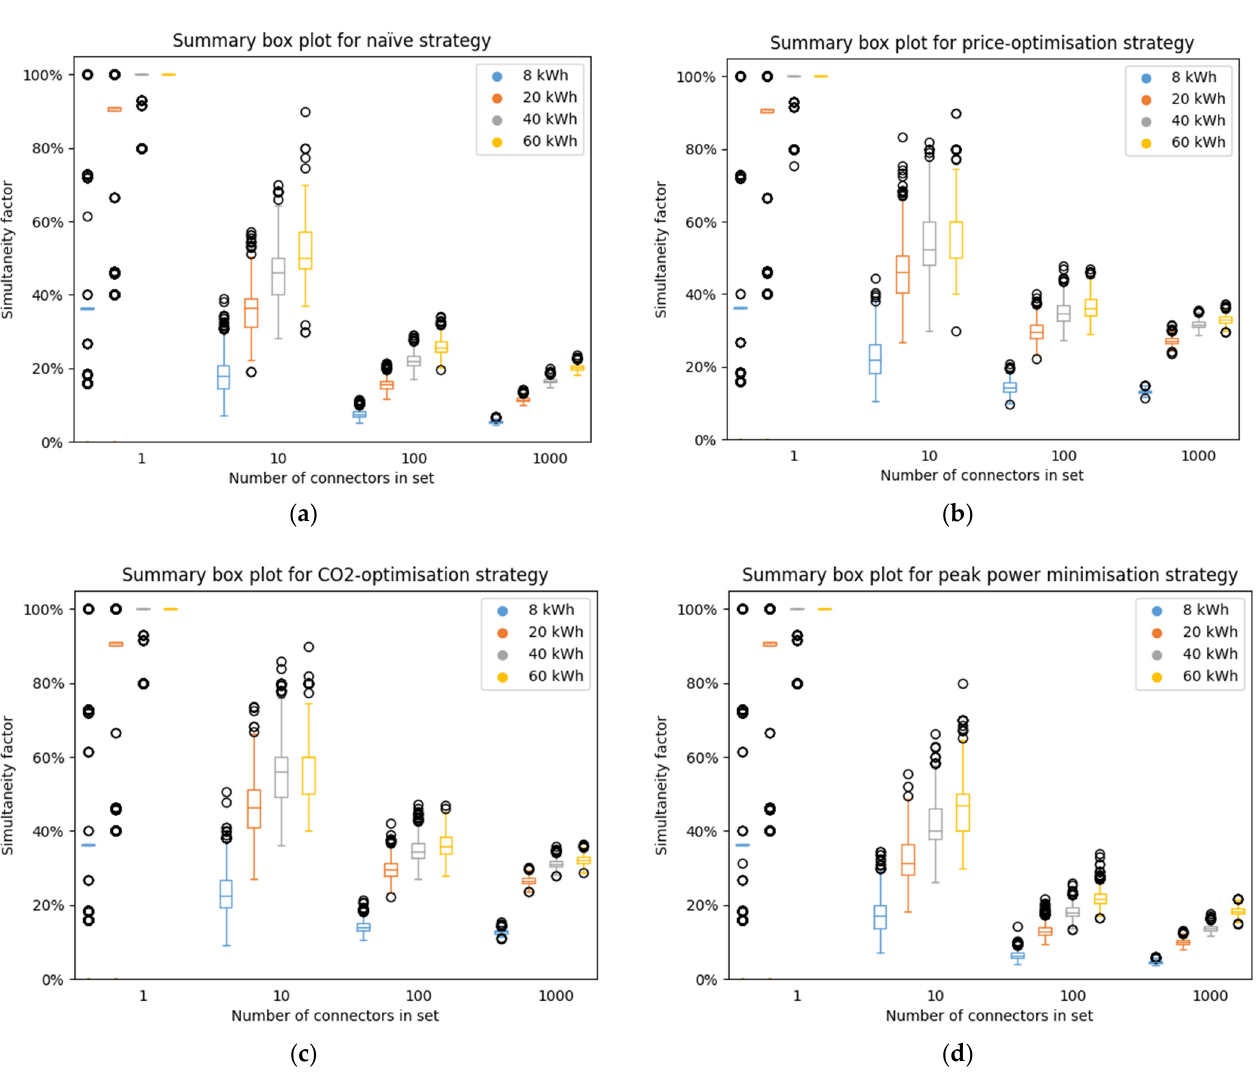
Figure 18. Summary of the simultaneity factors assuming for ( a ) naive charging; ( b ) price-optimised charging; ( c ) CO 2 intensity optimised charging; ( d ) peak power optimised charging. The plots summarise the information given in Figures A3–A6. For each combination of number of connectors per set and energy per charge event, 1000 sets were randomly created, and the results displayed in the box and whiskers plots in this figure. For example, when applying the CO 2 -optimisation strategy, a random selection of 100 connectors lead to a median simultaneity factor of 30% if a 20 kWh per charge event were assumed with outliers ranging from 20% to 42%.